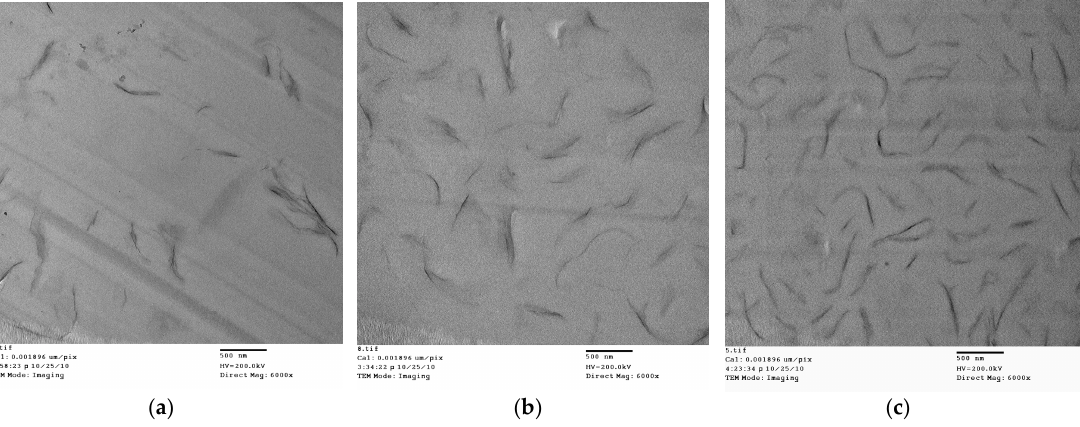
Figure 5. TEM micrographs of the D-clay epoxy at different weight loading. ( a ) 1 wt %; ( b ) 2 wt %; and ( c ) 5 wt %. The scale bar represents 500 nm in all figures.